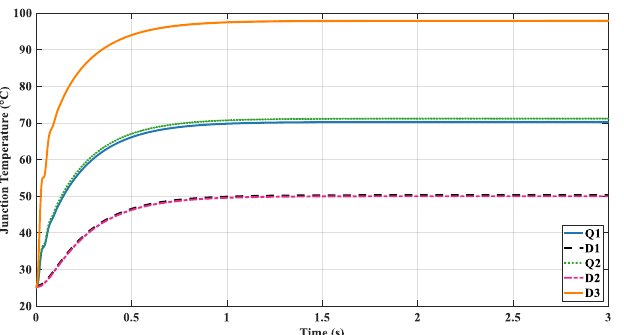
Figure 14. The junction temperature of the power semiconductors within the multi-switch boost converter.